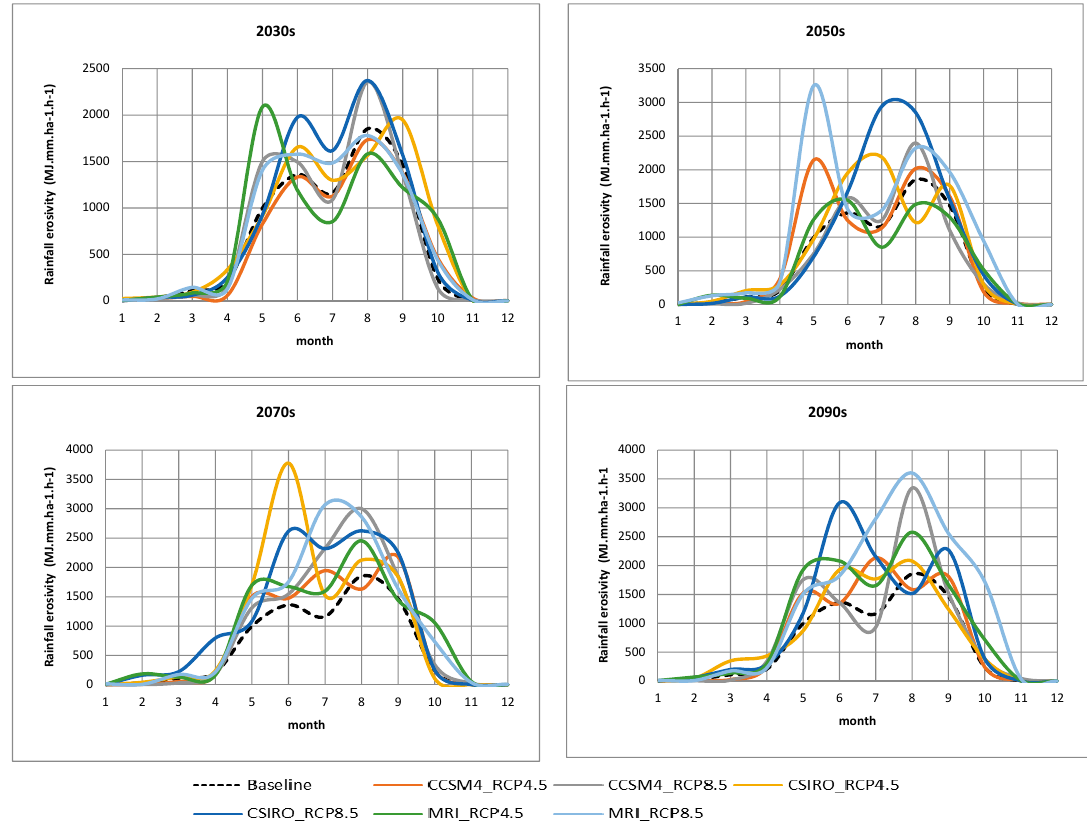
Figure 8. Rainfall erosivity for all climate projections for 2030s, 2050s, 2070s, 2090s and the baseline period (1982–2005) for the Huai Luang watershed.